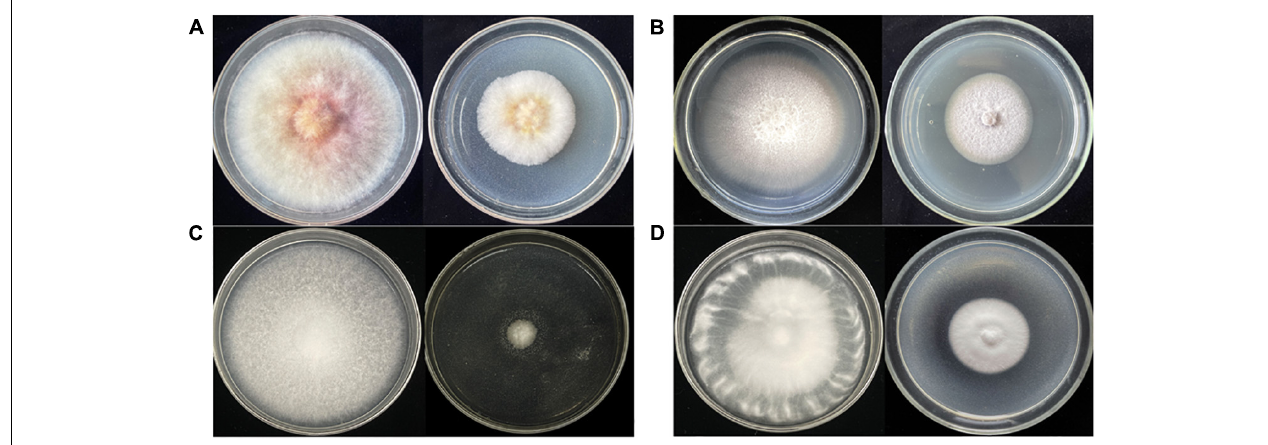
FIGURE 3 | Antifungal activity of the crude extract from strain AC1. (A) F. graminearum ; (B) F. moniliform e; (C) B. cinerea ; (D) V. dahlia (left: control group; right: experimental group).